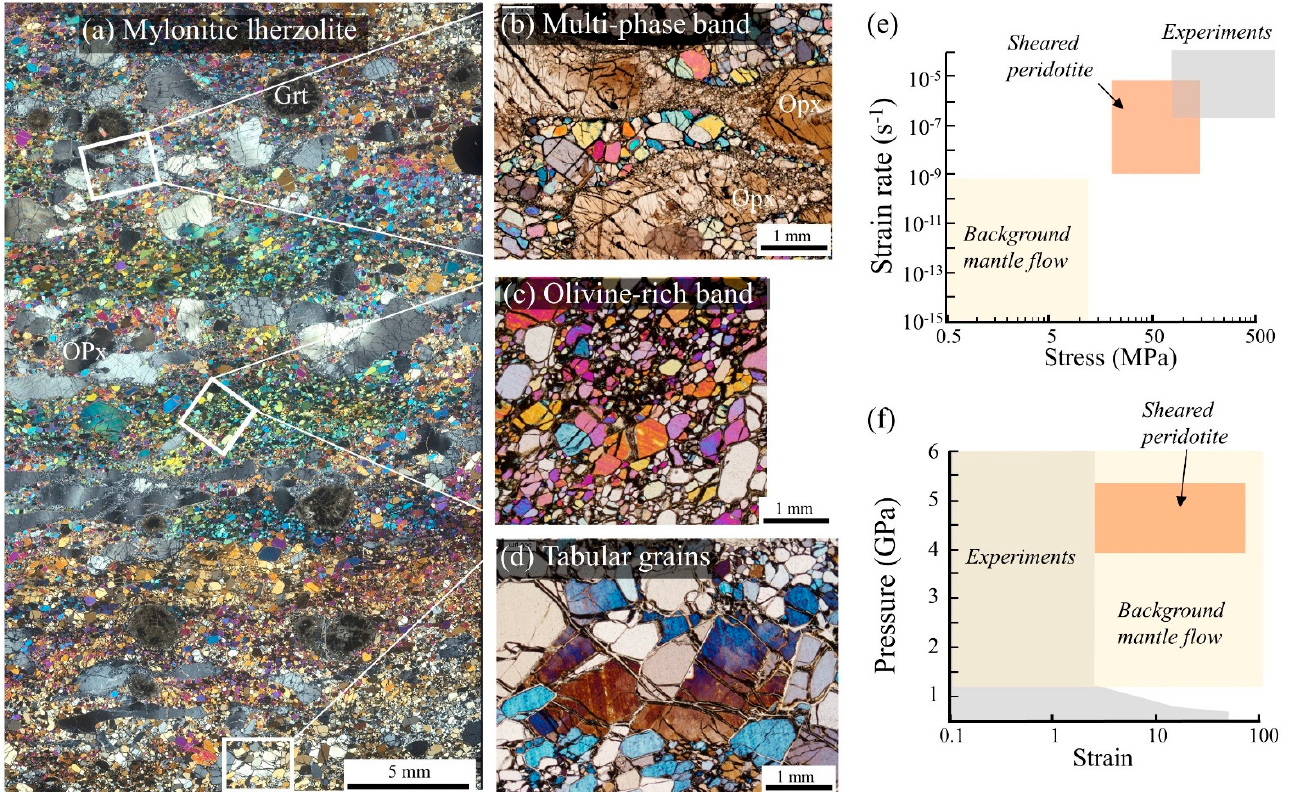
Figure 1. ( a ) Optical photomicrographs taken with cross-polarized light of sample H69-15F. North-South is normal to the foliation, and East-West is parallel to the lineation. White boxes delineate the main microstructural features in ( b – d ). ( b ) Multiphase band comprise olivine, orthopyroxene (Opx), and/or garnet (Grt). ( c ) Olivine-rich band. ( d ) post- deformation, tabular-shaped olivine grains growing into deformed grains with undulatory shading. The formation and growth kinetics of the tabular-shaped olivine grains were discussed in Boneh et al. [46]. ( e ) Microstructural analysis and thermobarometry indicate high stress and high strain rates for the H69-15F sheared lherzolite—comparable to the laboratory conditions. ( f ) Schematic plot of pressure versus strain illustrating the deformation conditions for the sheared peridotite, along with the common conditions of background mantle flow, which are, for the most part, yet inaccessible in the laboratory.